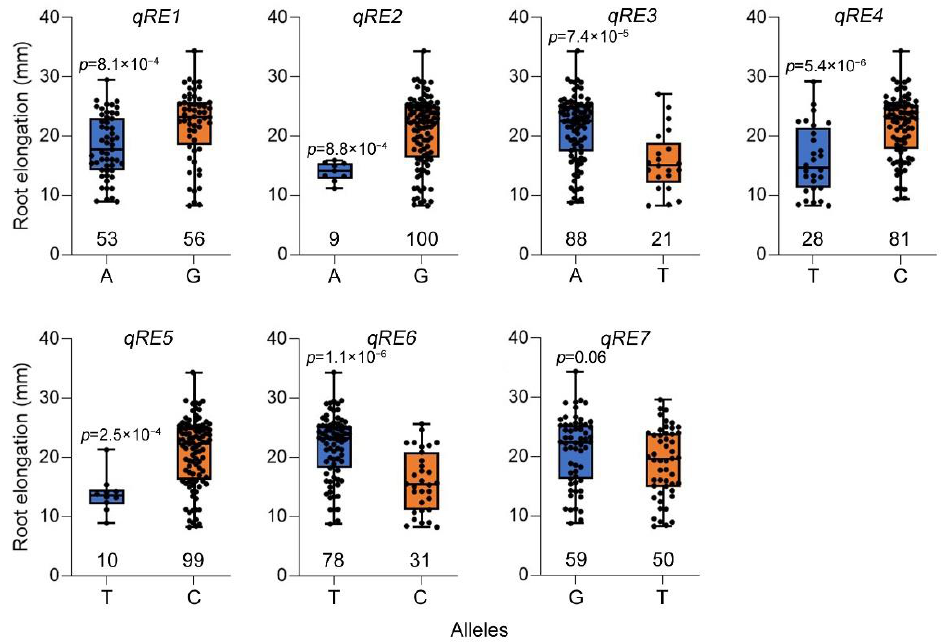
Figure 2. Effect analysis of allelic variations on root elongation under high Zn